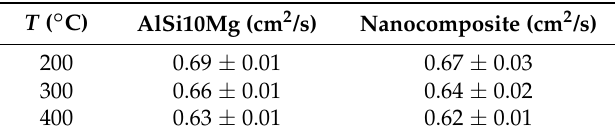
Table 3. Average thermal diffusivity values with their standard deviation obtained for AlSi10Mg alloy and nanocomposite samples.